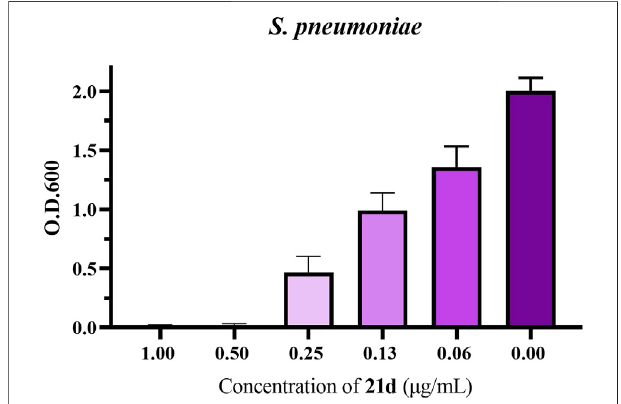
FIGURE 7 | The in fl uence of S. pneumoniae bio fi lm formation treated with 21d . Bio fi lm formation (O.D.600) of S. pneumoniae (ATCC 49619) in 96- well plates was quanti fi ed in the presence of 21d after 20 h. The error bar represents the standard error of the average calculated using data from at least three independent